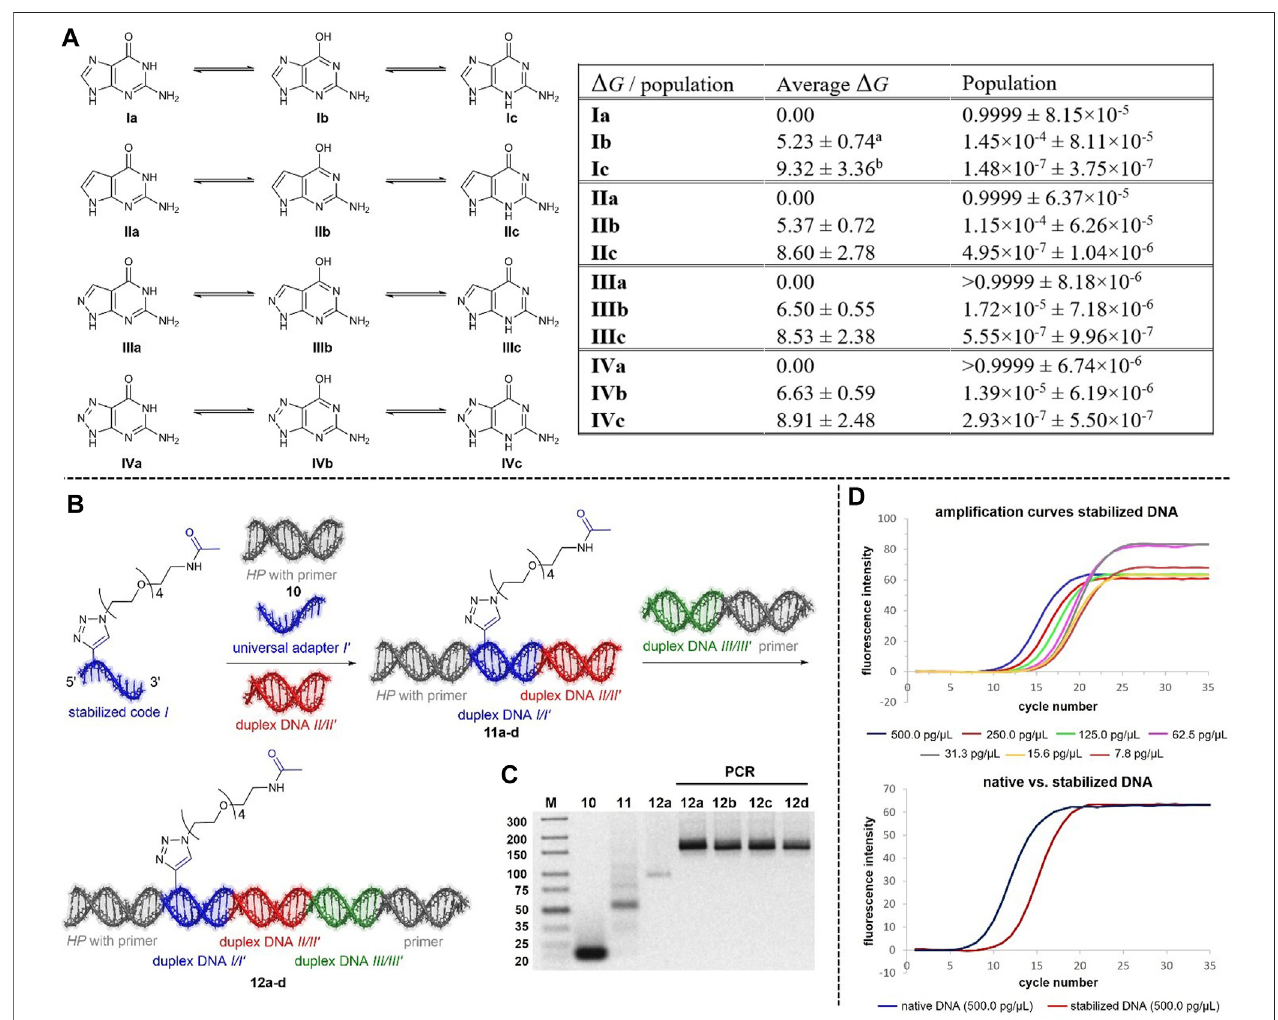
FIGURE 2 | (A) Calculated standard reaction free energies Δ G (kcalmol − 1 ) and populations for selected tautomeric forms of guanine derivatives I-IV relative to the Watson-Crick tautomers [ I - IVa ] accompanied by uncertainties from averaging over a range of methods c . See SI for computational details. a Eberlein, 2020: 6.6 ± 0.7 kcal mol − 1 , b Eberlein, 2020: 7.5 ± 1.5 kcal mol − 1 , c Note that the uncertainties provided in Eberlein, 2020 and Potowski, 2021 were erroneously reported to be too small by a factor of 5 1/2 = 2.236. Uncertainties are here correct, and the corrected values are also given for reference calculations (Eberlein, 2020) on